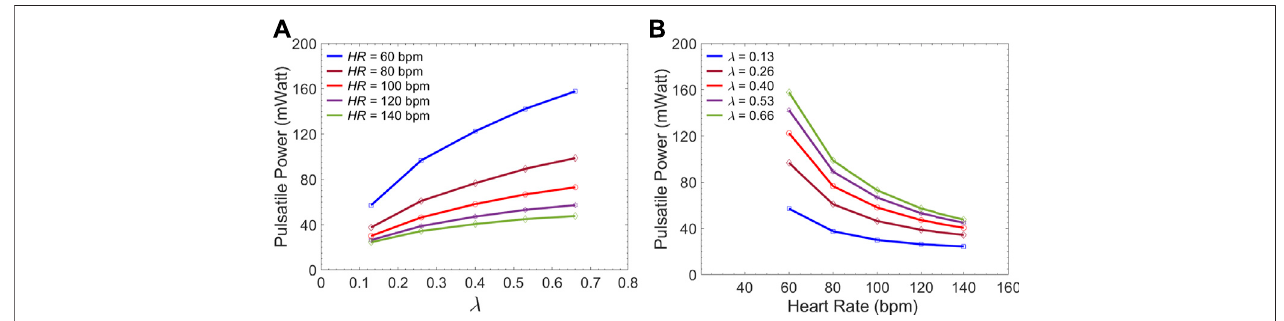
FIGURE 7 | Average LV pulsatile power requirement per cardiac cycle versus (A) the λ (endograft-septum length ratio) at different HRs and versus (B) the HR at different λ .